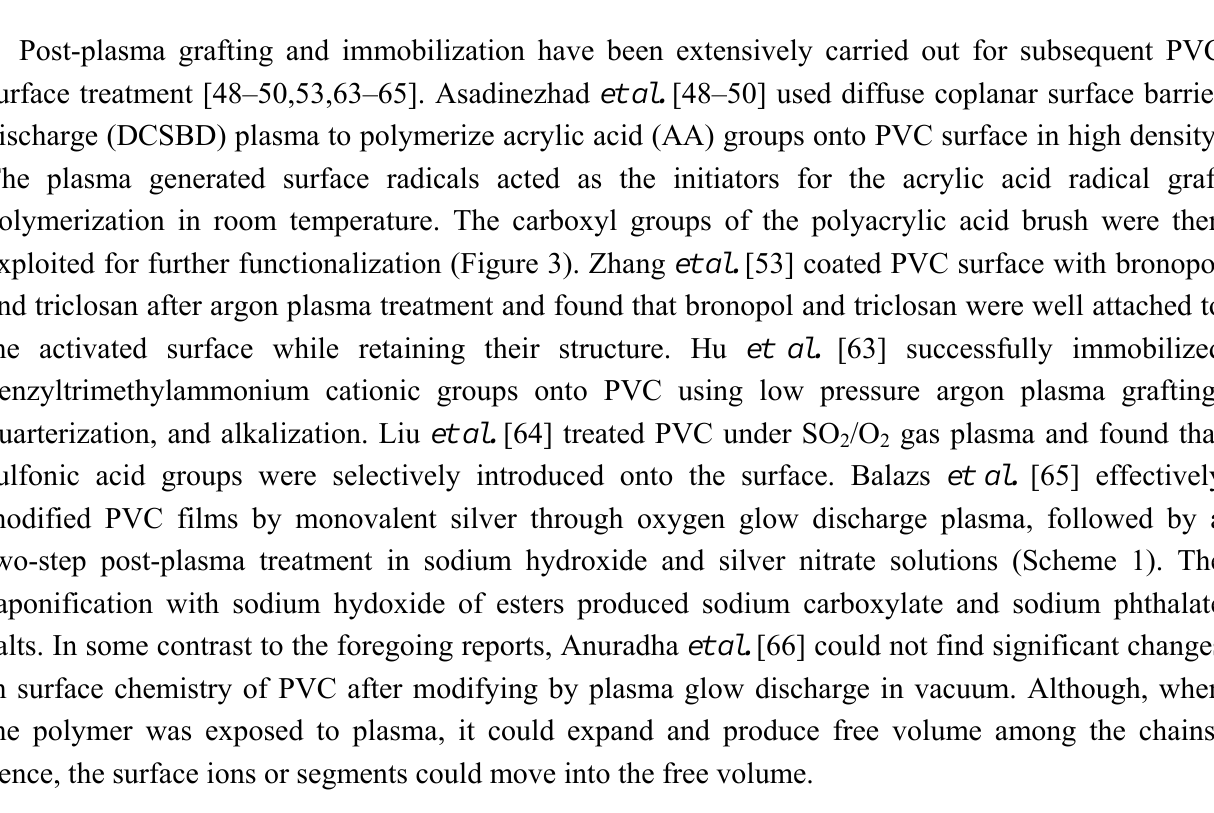
Figure 3. A schematic graph of ( a ) DCSBD plasma device; ( b ) multistep approach pursued to modify PVC surface (Reproduced with permission from [50]. Copyright 2010